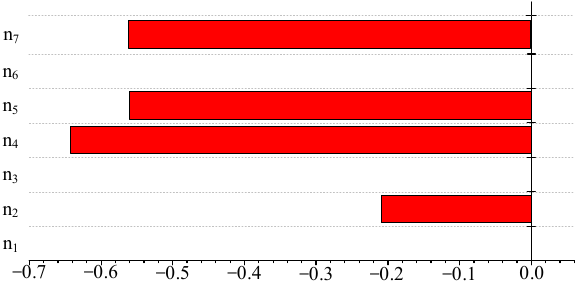
Figure 24. Correlation of 7 optimization parameters to natural frequency sensitivity.